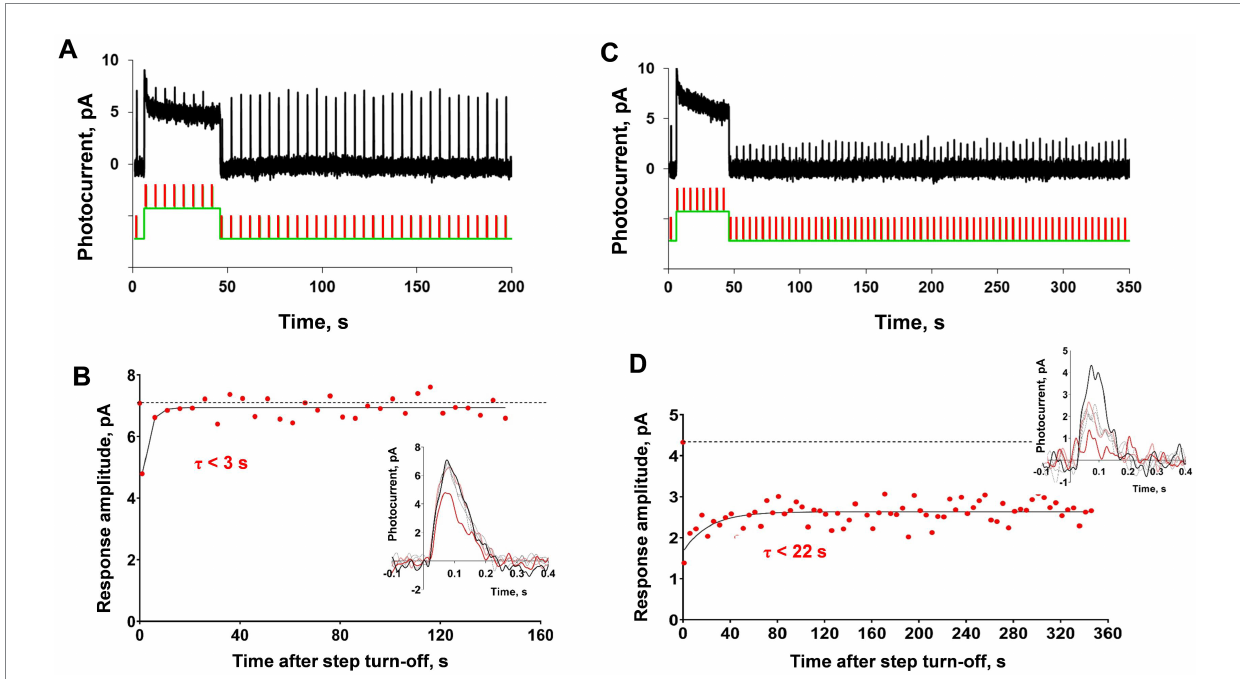
FIGURE 5 Analysis of ‘adaptation memory’ in a single red-sensitive cone of Carassius gibelio . (A) Response representative of the cone compared to the combination of the green light step (duration 40 s, intensity 6.5×10 4 photons· μ m − 2 ·s − 1 , 525 nm) with brief light flashes (2 ms, intensity 8,170 photons· μ m − 2 , 630 nm), and (B) shows dynamics of the response amplitude recovery after the initial step. (C) Recordings from the same cone under the same protocol of stimulation but the intensity of the light step is one order of magnitude higher (duration 40 s, intensity 8.2×10 5 photons· μ m − 2 ·s − 1 , 525 nm) and (D) dynamics of the response amplitude recovery for the record (C) . In panels (B) and (D) for reference, the points plotted at time zero and dashed lines illustrate the pre-step